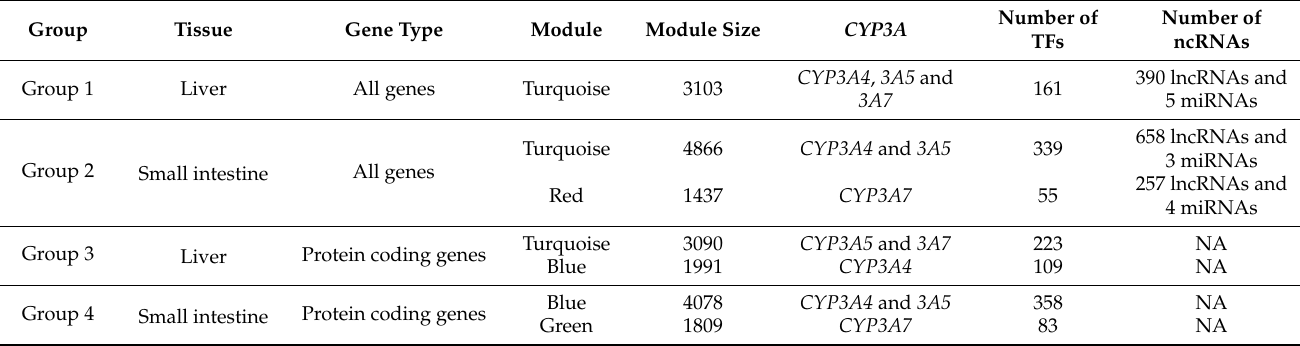
Table 2. Modules containing CYP3As identified from group 1 to 4 using weighted gene co-expression network